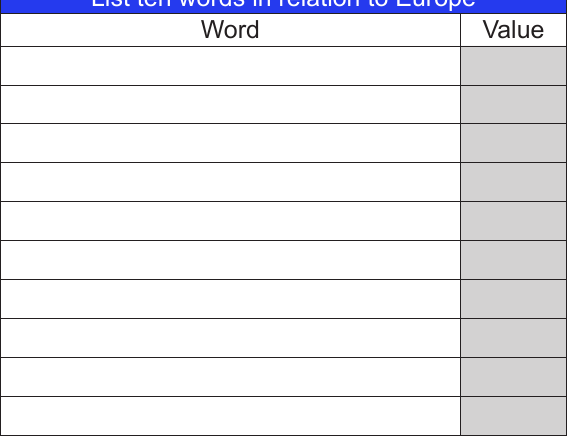
Fig. 1. An associated word test proposed for